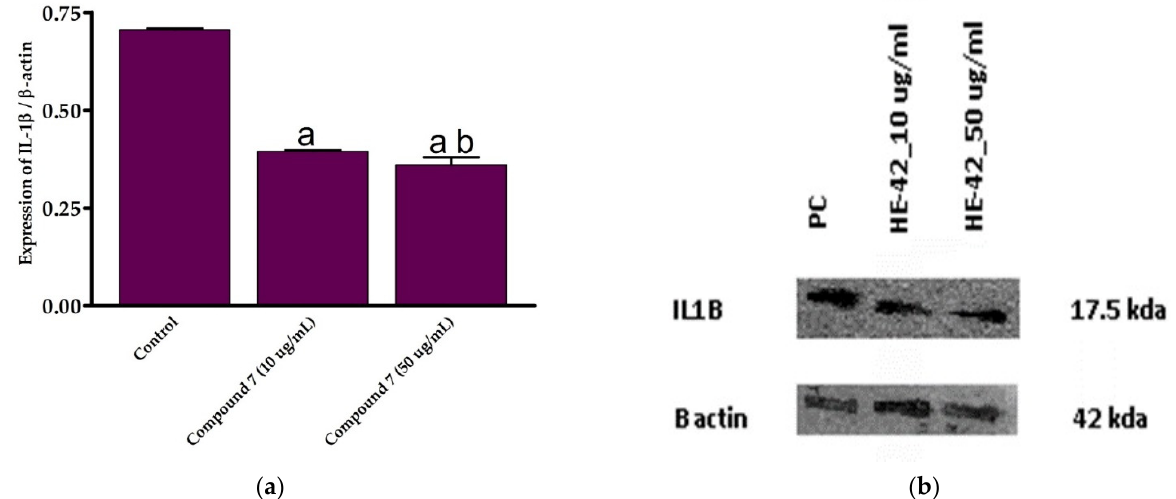
Figure 6. In vitro anti-inflammatory effect of compound 7 against LPS-activated RAW264.7 cell line. ( a ) Expression of IL-1 β at different concentration of compound 7; ( b ) Western plot analysis of the expression of IL-1 β . Data are shown as mean ± SD. a p < 0.05 versus control cells and b p < 0.05 versus compound 7 (10 µg/mL).